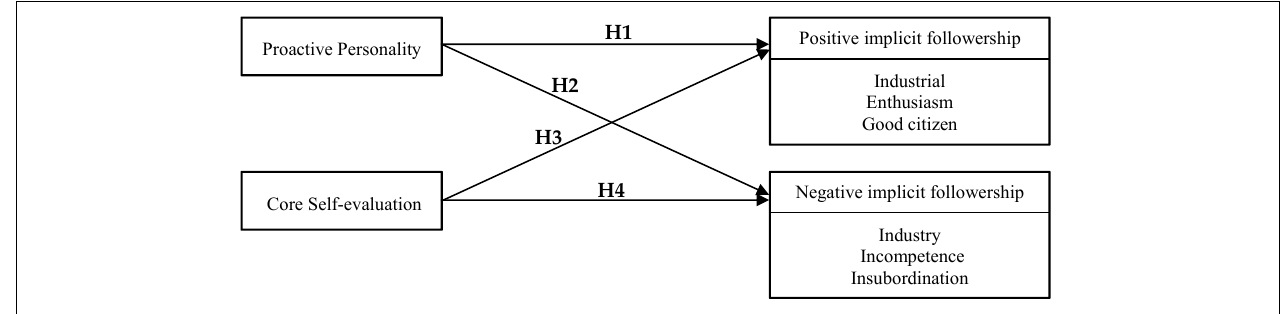
FIGURE 1 | Theoretical framework.